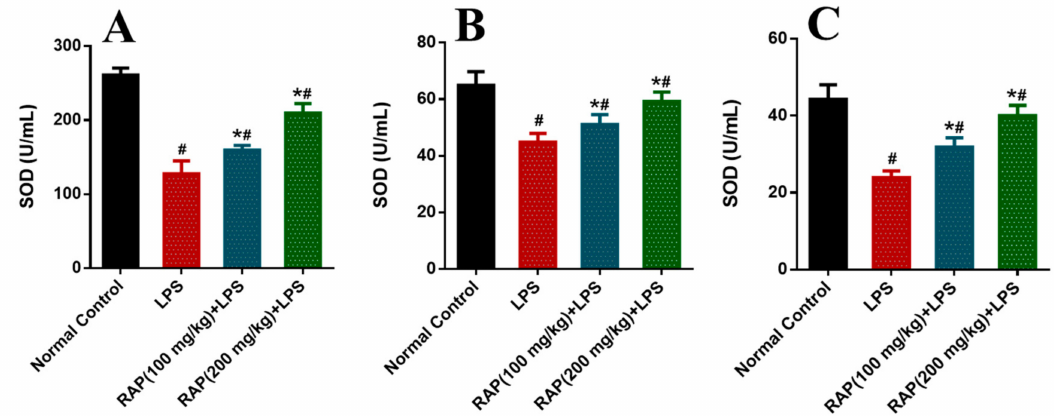
Figure 1. Determination of SOD in ( A ) plasma, ( B ) Liver and ( C ) Brain. Results are mean SEM of seven animals per group. ‘*’ denotes significant di ff erences compared with the normal control group ( p < 0.05); ‘#’ denotes significant di ff erences compared with the LPS group ( p < 0.05).